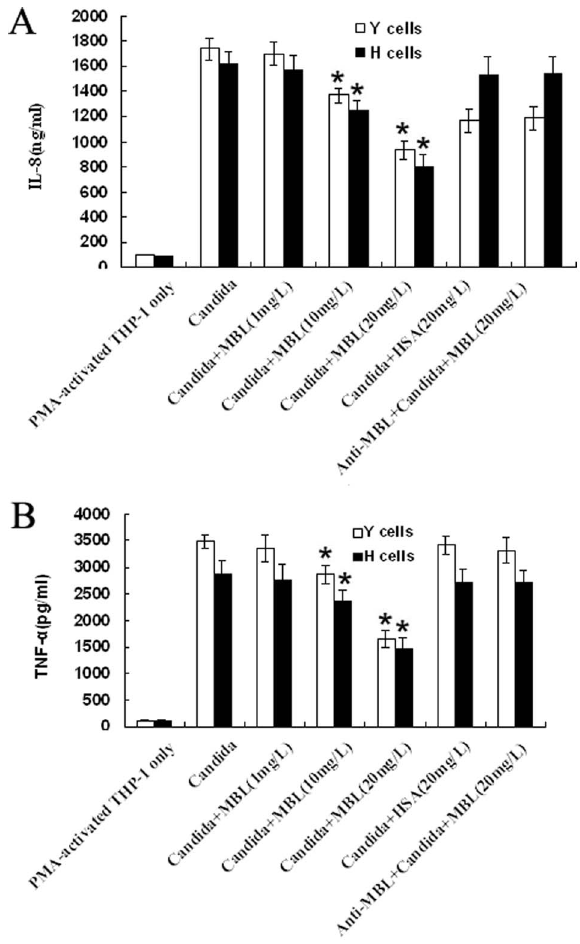
Figure 3. MBL inhibits C. albicans -induced IL-8 and TNF- a productions from PMA-activated THP-1 cells. PMA-activated THP- 1 cells were stimulated with HK Y or H cells of C. albicans at a Candida/ THP-1 ratio of 2:1 in the presence of the indicated concentrations of MBL, anti-MBL pAb and MBL, or HSA for 24 h. Supernatants were harvested and subjected to ELISA for IL-8 (A) and TNF- a (B). The data are expressed as mean 6 SD of four independent experiments. *P , 0.05 as compared to C. albicans -stimulated group. Similar results were observed in four independent